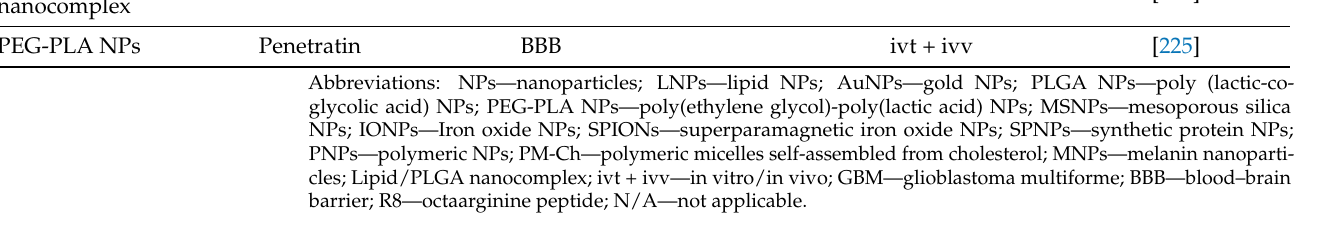
Table 3. Application of chemical effects to change the permeability of histohematic